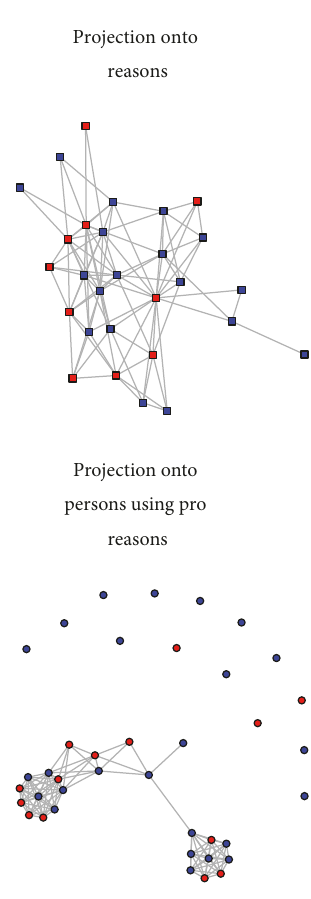
Figure 1: An example of a bipartite adversarial policy network around the issue of speeding up naturalization of foreigners in Switzerland (based on empirical results of a study described later in the paper). (a) The bipartite network composed of persons and the reasons they acknowledge. (b) Projections of the bipartite network onto persons, where individuals are connected if they share at least one reason, or onto reasons, where reasons are connected if they are both produced by the same person. Blue indicates reasons or persons favoring reduced naturalization times and red indicates reasons or persons against reduced naturalization times. (c) The person projections based on bipartite networksconstrained to only contain eitherproor con reasons. Blueindicatespersons favoringreduced naturalizationtimes and red indicates persons against reduced naturalization times; persons’ attitudes towards the policy issue were assessed using a separate survey item.